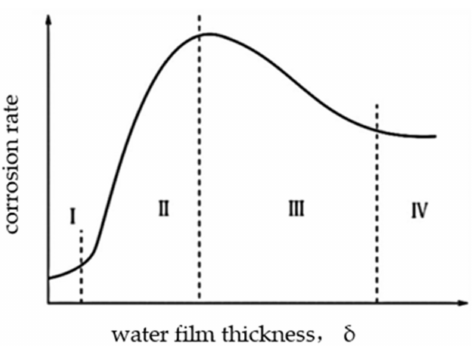
Figure 1. Relationship between atmospheric corrosion rate and metal surface water film thickness [7] I. δ = 1–10 nm II. δ = 10 nm–1 µ m III. δ = 1 µ m–1 mm IV. δ > 1